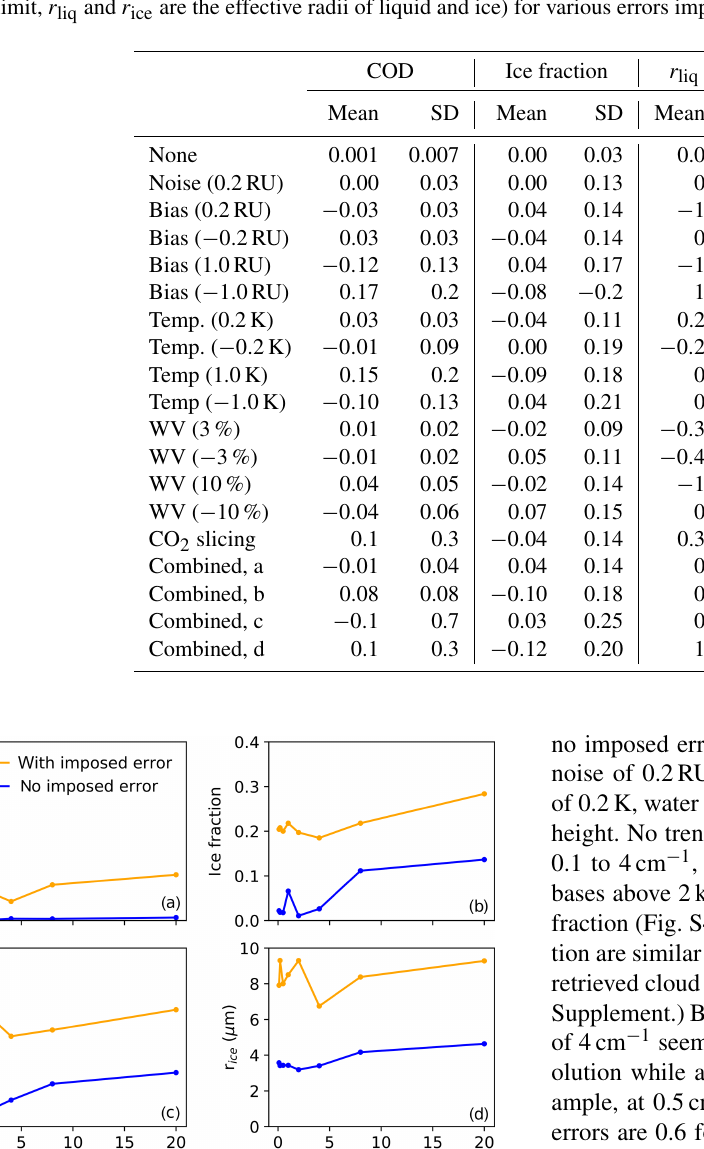
Table 4. Errors in retrieved cloud properties (mean error and standard deviation of error; SD; COD refers to cloud optical depth in the geometric limit, r liq and r ice are the effective radii of liquid and ice) for various errors imposed on the observations (see text).